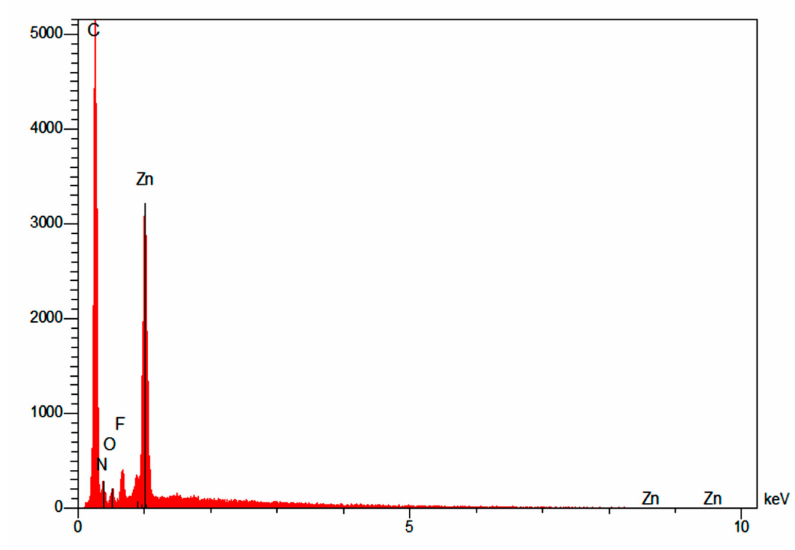
Figure 7. EDX spectra performed on the small aggregates observed in PEI/10 wt% ZIF-8.